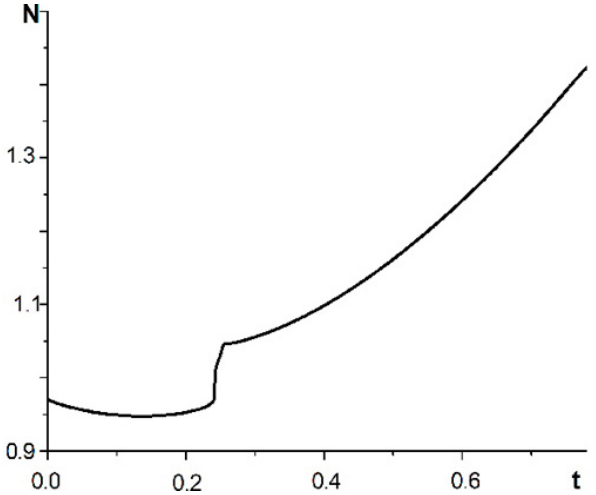
Fig. 7. Wave refractive index versus time for the wave packet ini- tially propagating to the Earth with k r = − 0 . 2 , k θ = 0, and k ϕ = 0 . 95.